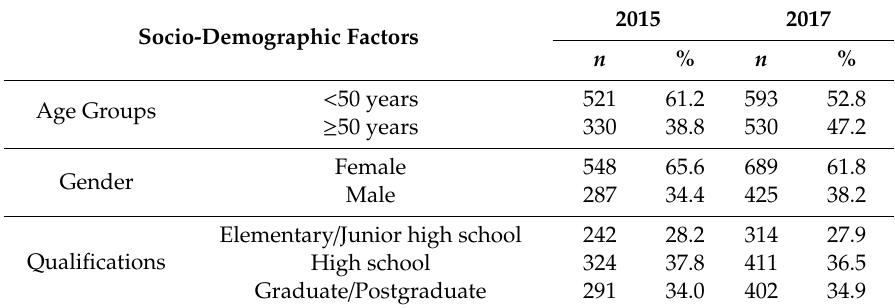
Table 2. Age groups, sex, and qualifications among study participants in 2015 and